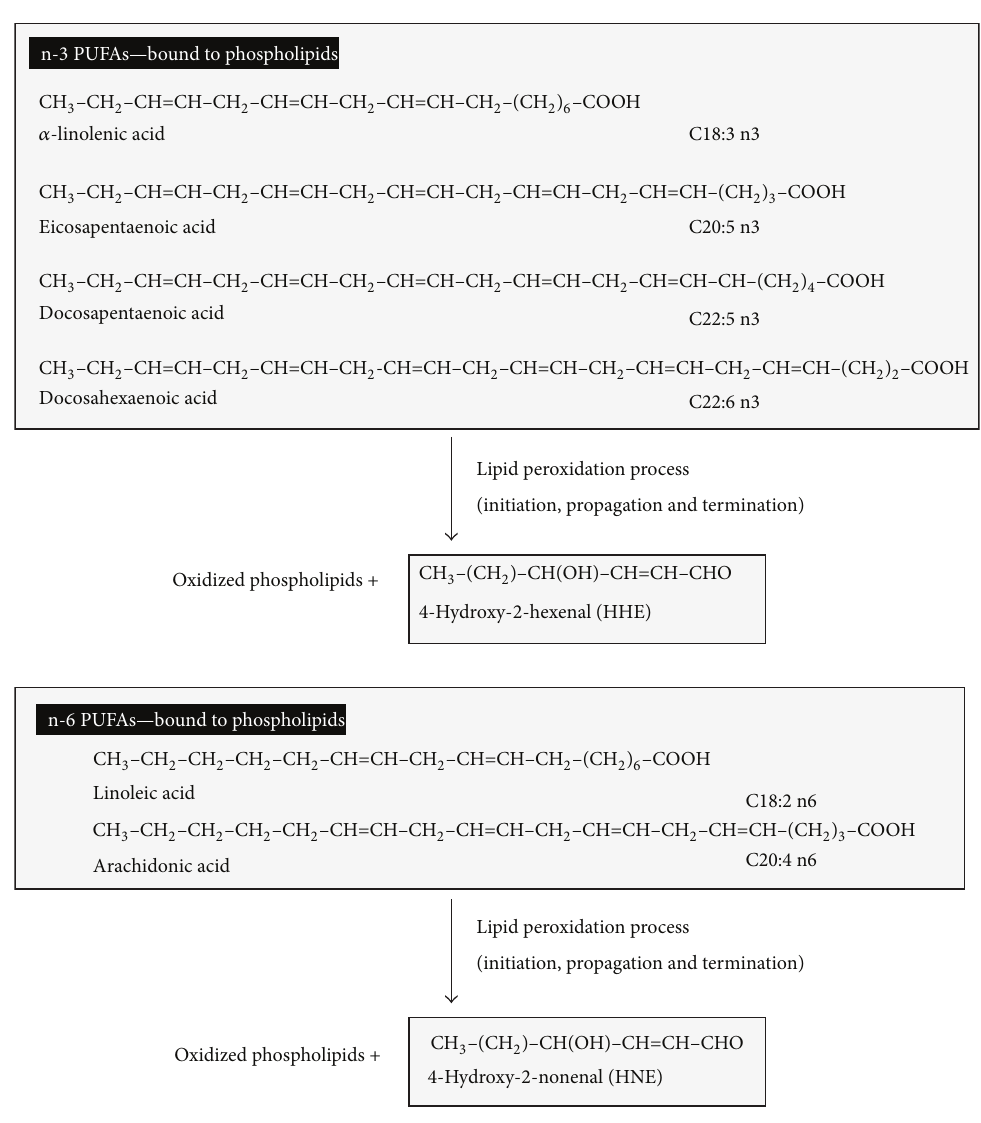
Figure 6: Schematic diagram of reactive hydroxy-alkenals generated during lipid peroxidation of n-3 and n-6 polyunsaturated fatty acids.